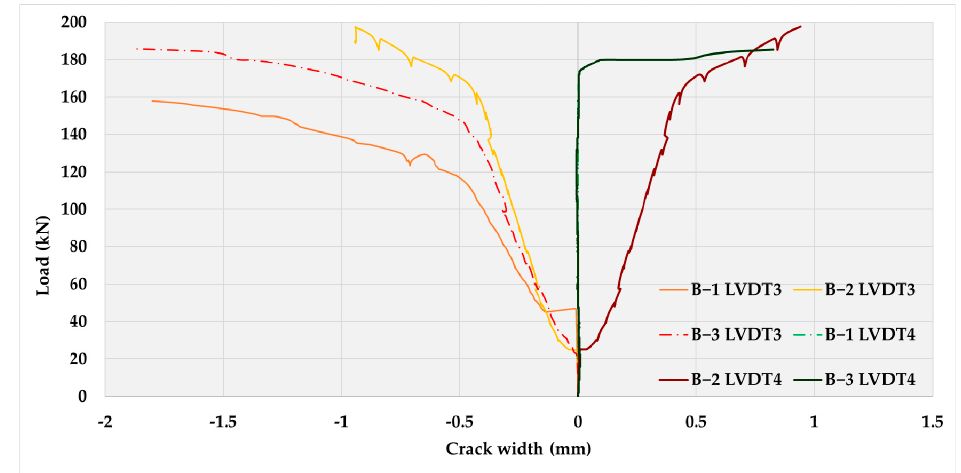
Figure 7. Comparative load vs. crack width diagrams obtained using LVDT 3 in Section I and LVDT 4 in Section III.